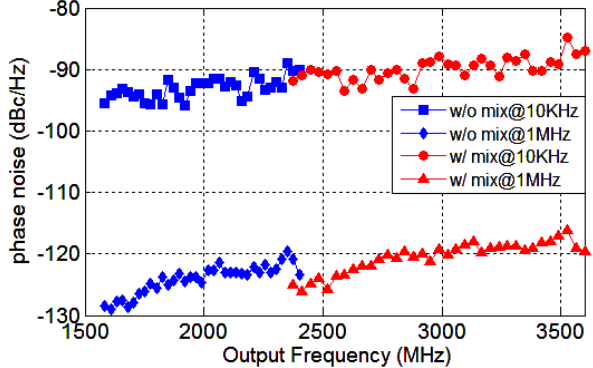
Figure 17 . Summarized phase noise performance from 1.6 to 3.6 GHz. Figure 17. Summarized phase noise performance from 1.6 to 3.6 Table 2. Performance comparison with the referenced works.